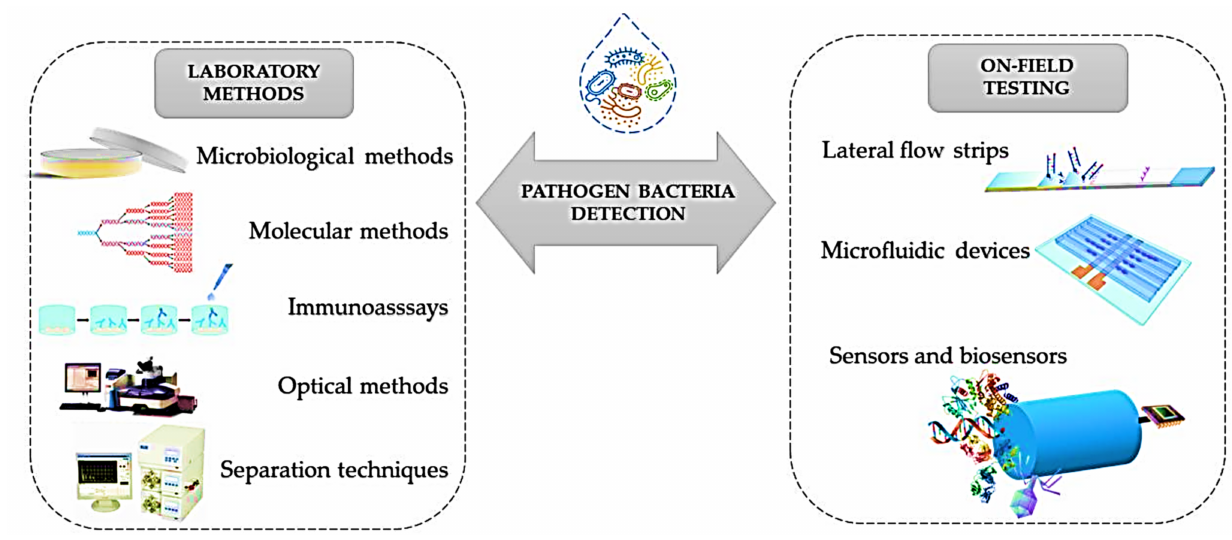
Figure 11. Schematic representation of the current analytical methods and POC devices applied to detect E. coli Reprinted from ref.